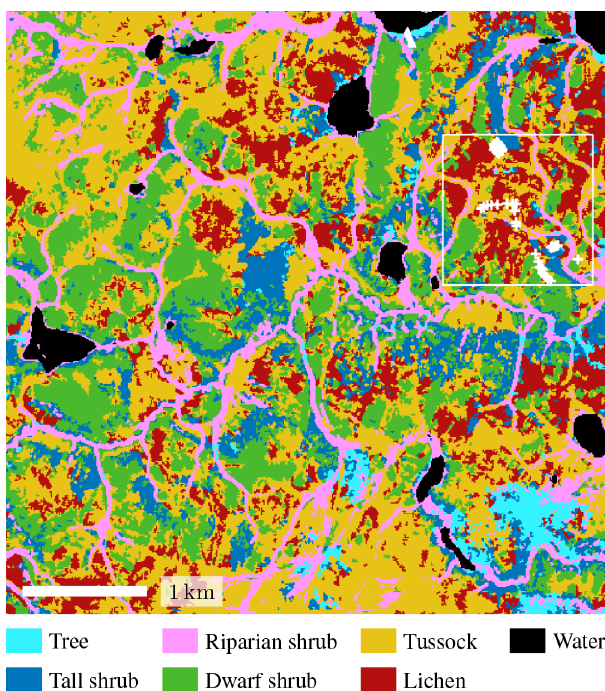
Figure 2. Vegetation map of the study region using the vegetation types as described above (Grünberg and Boike, 2019); the map is based on airborne orthophotos and vegetation height derived from airborne laser scanning (Anders et al., 2018); the white square indi- cates the study site extent including all sensor locations (white plus signs) as shown in Fig.